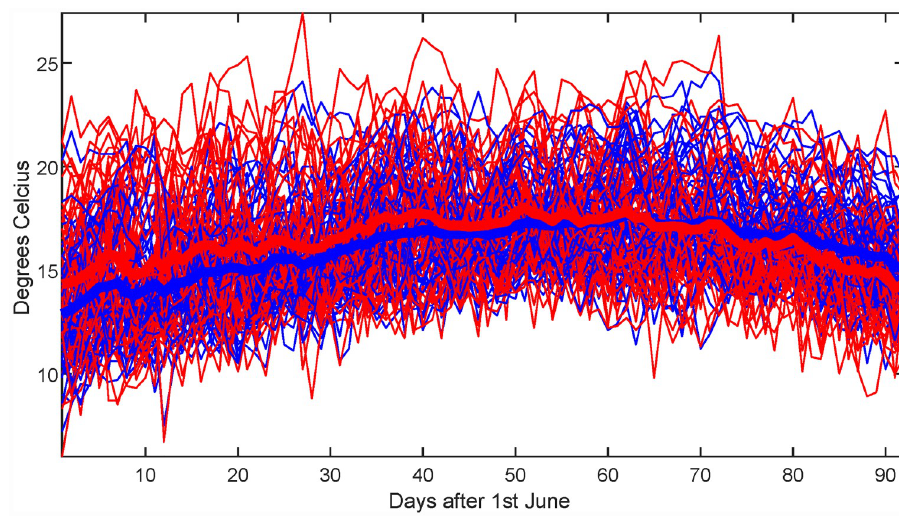
Fig 10. Temperature data from Ferder (blue) and Fornebu (red) and mean values marked by thick